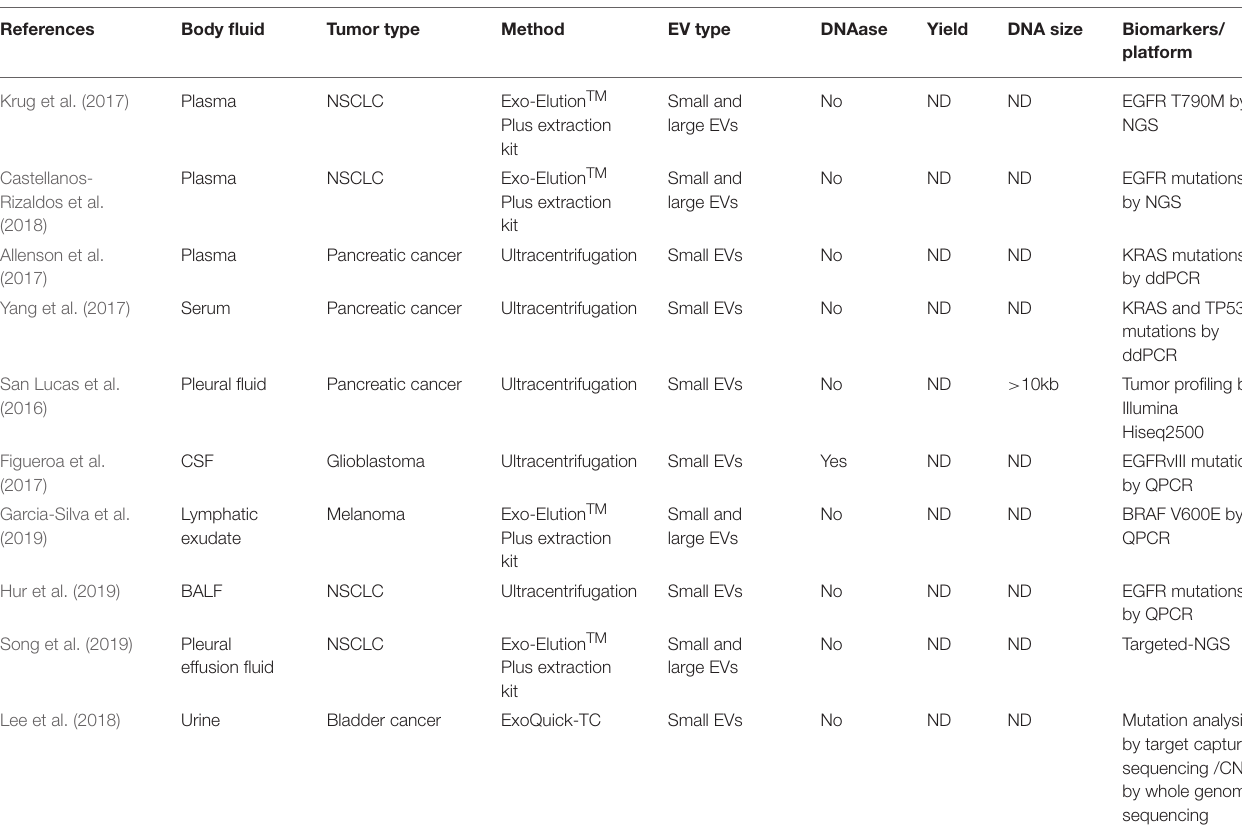
TABLE 1 | Summary of the main reports performing DNA-EV analyses for liquid biopsy